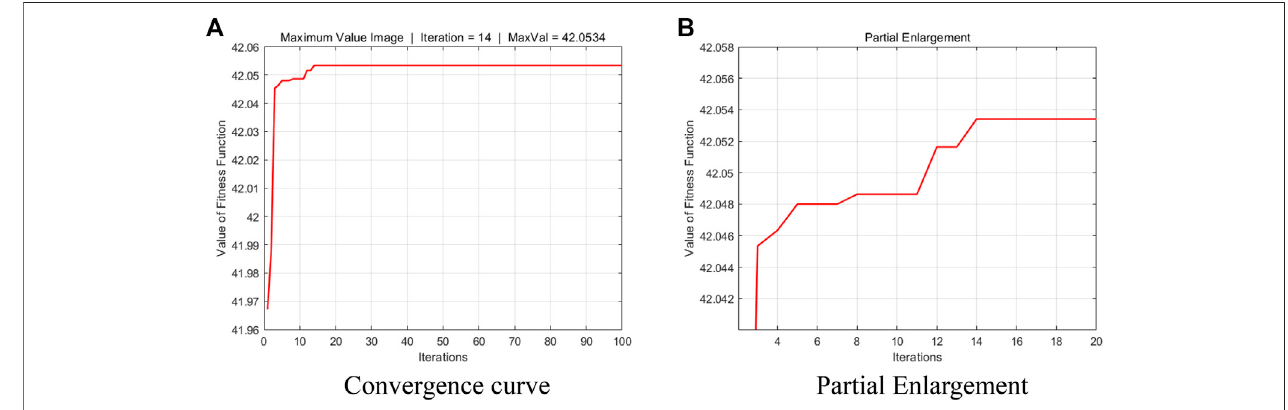
FIGURE 9 | Convergence curve of arti fi cial bee colony algorithm. (A) Convergence curve (B) Partial